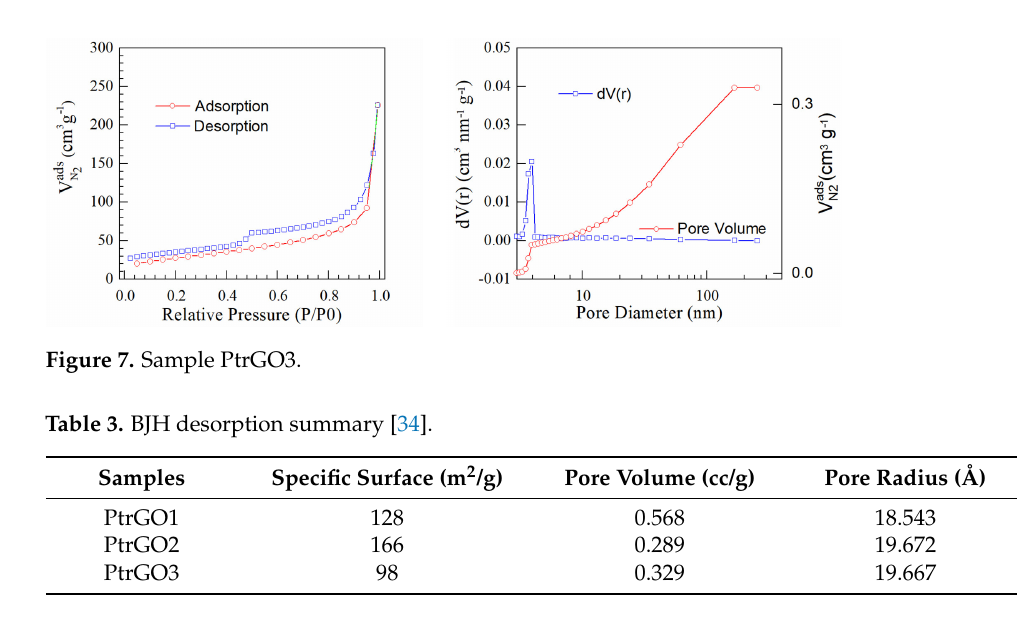
Figure 6. Sample PtrGO2.